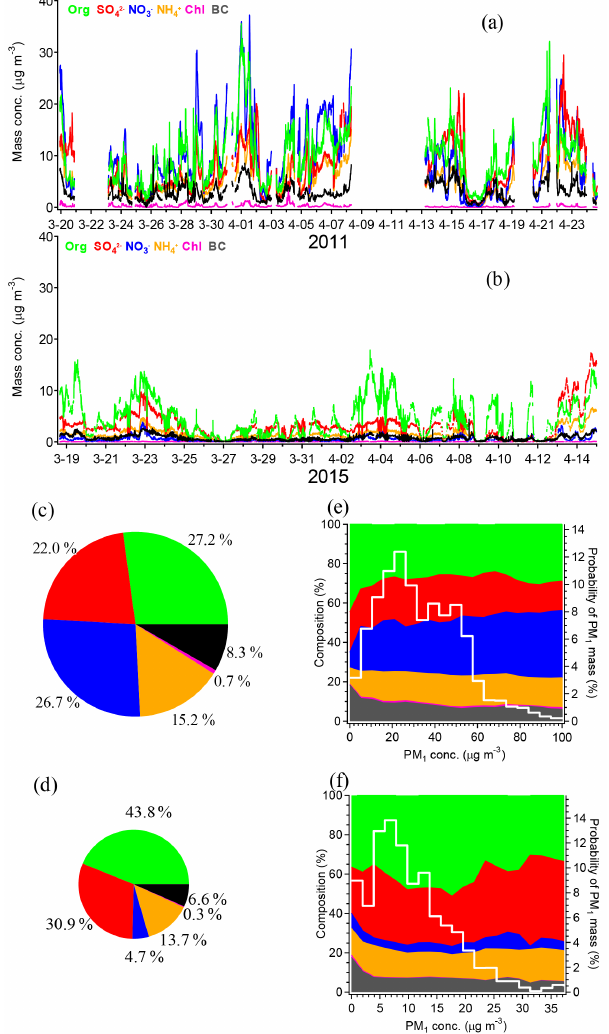
Figure 2. Time series of AMS species and BC at (a) NCB and (b) SCB, the average PM 1 chemical compositions at (c) NCB and (d) SCB (areas of pie charts are sized by PM 1 mass loading), evolutions of PM 1 compositions (left axis) as a function of PM 1 mass loading, and the probability distributions of PM 1 mass loading (white line to right axis) at (e) NCB and (f)